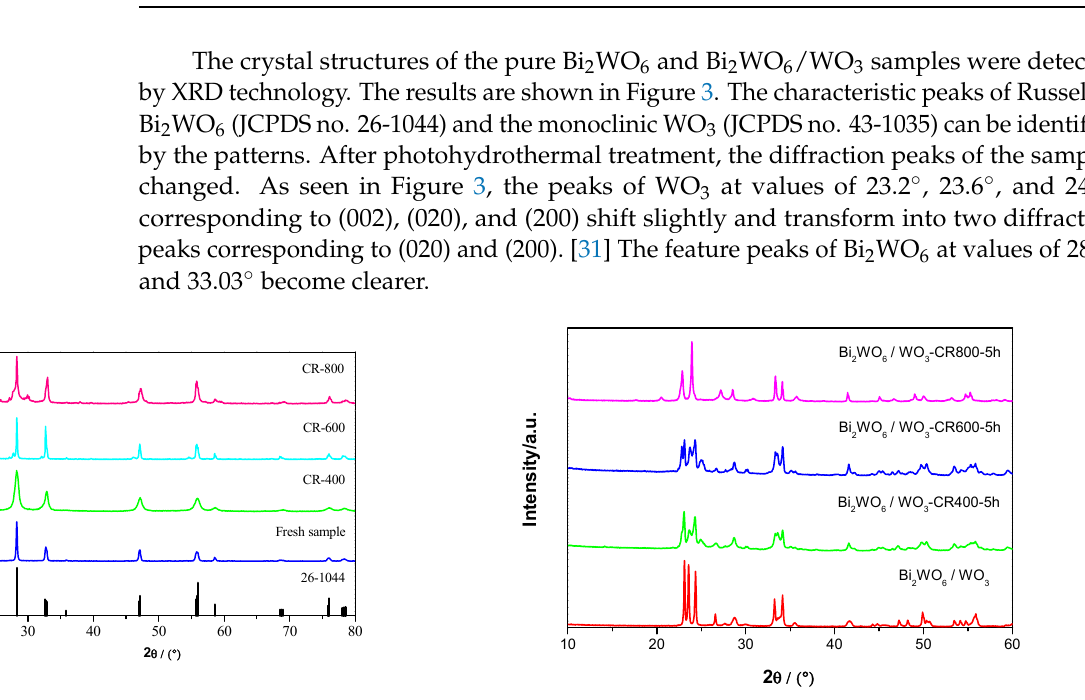
Figure 3. XRD patterns of parent and photohydrothermally treated Bi 2 WO 6 and Bi 2 WO 6 /WO 3 under different concentration ratios: ( left ) Bi 2 WO 6 ; ( right ) Bi 2 WO 6 /WO 3 .